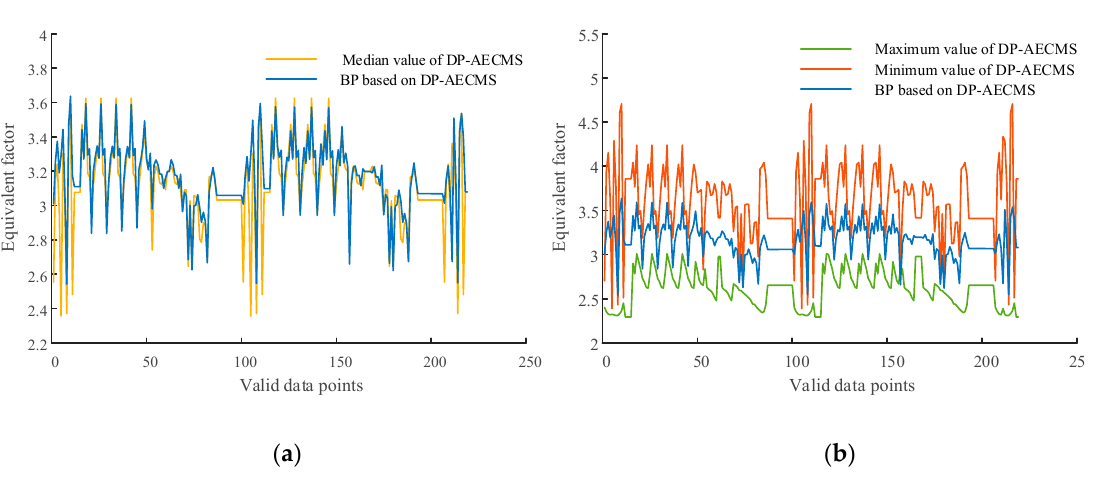
Figure 11. Equivalent factors of the neural network strategy, ( a ) Recognition error of BP neural network; ( b ) Allowable range of equivalent factor.